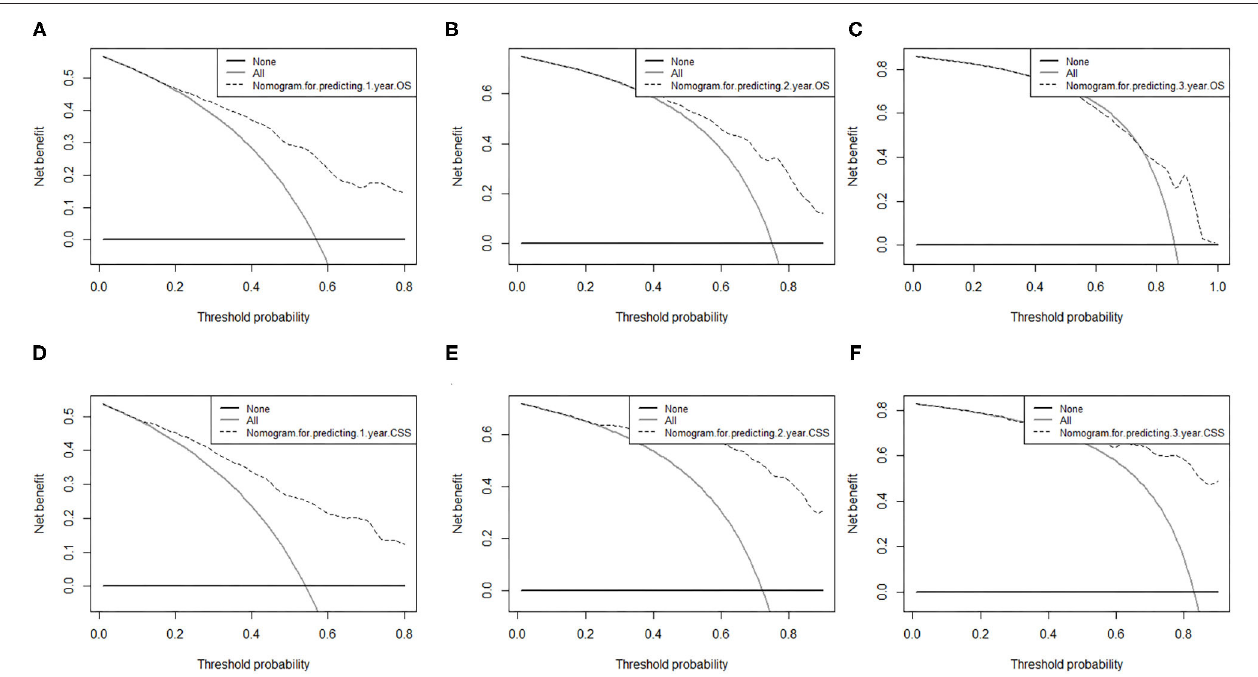
FIGURE 7 | Decision curve analysis of nomograms for predicting (A) 1-year OS; (B) 2-year OS; (C) 3-year OS and (D) 1-year CSS; (E) 2-year CSS; (F) 3-year CSS. OS, overall survival; CSS, cancer-specific survival. The dashed lines indicate the net benefit of the models across a range of threshold probabilities. The horizontal solid black line represents the hypothesis that no patients experienced the endpoint, and the solid gray line represents the hypothesis that all patients met the endpoint. At different threshold probabilities within a given population, the number of high-risk patients and the number of high-risk patients with the outcome were plotted.